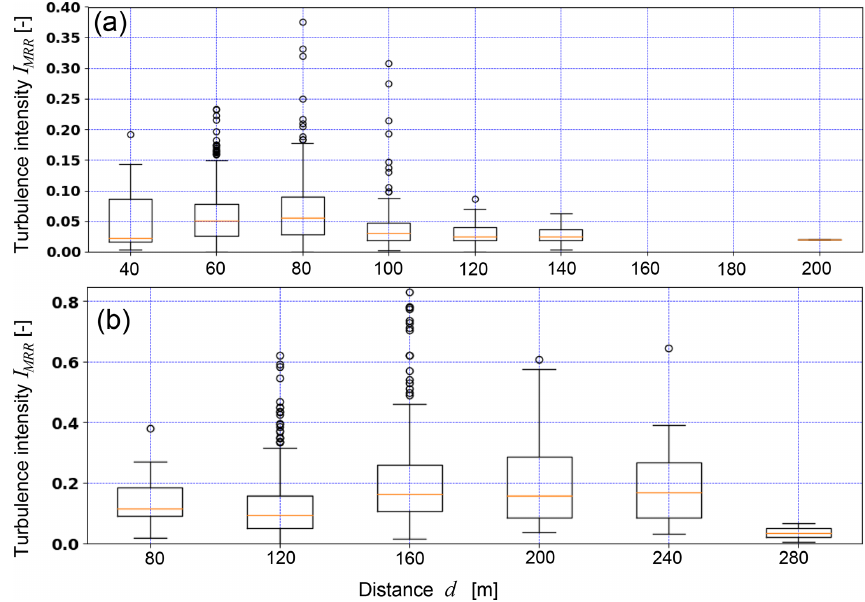
Figure 10. Turbulence intensity determined from the MRR spectral width of the Doppler spectrum of the range gate defining the blowing snow transport distance (Fig. 4a) as a function of transport distance for (a) EP1 and (b)